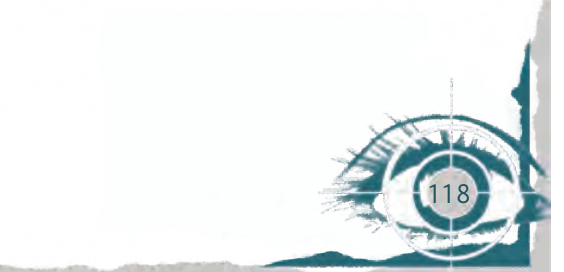
Figure 5 A pencil with divergency 4/ LJM += D at T. The antisymmetric contribution to M causes the two principal meridional planes and line foci to rotate towards each other and an meridional plane at 135 °− 64 . Relative to their positions in Figure 4 the focal planes have moved further apart. (b) azimuth °− 64 27 °− 64 , elevation 38 °− 64